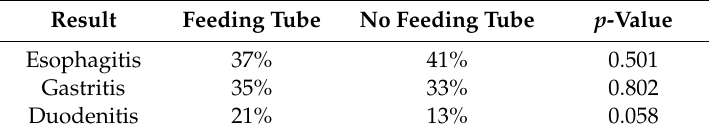
Table 3. Frequencies of biopsy results in patients with and without a feeding tube.